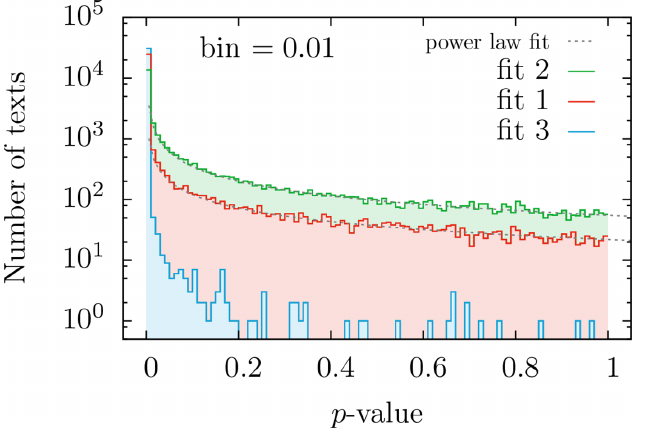
Fig 2. Histograms of p -values obtained when the Zipf-like distributions f 1 , f 2 , and f 3 are fitted to the texts of the English Project Gutenberg. The histograms just count the number of texts in each bin of width 0.01. Note the poor performance of distribution 3 and the best performance of 2. Power-law approximations to the histograms for f 1 and f 2 , with respective exponents 0.74 and 0.78, are shown as a guide to the eye.